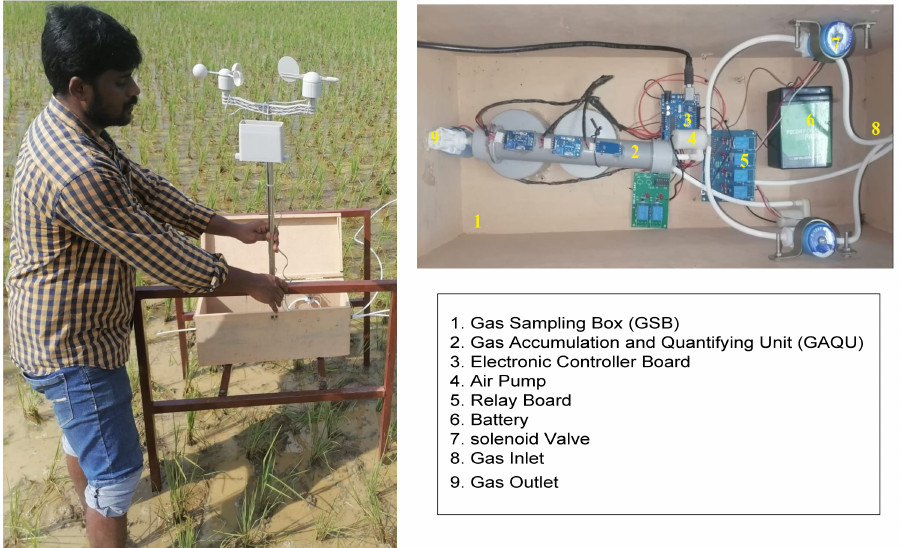
Figure 5. Photocopy of developed Gas sampling box with GAQU installed in rice